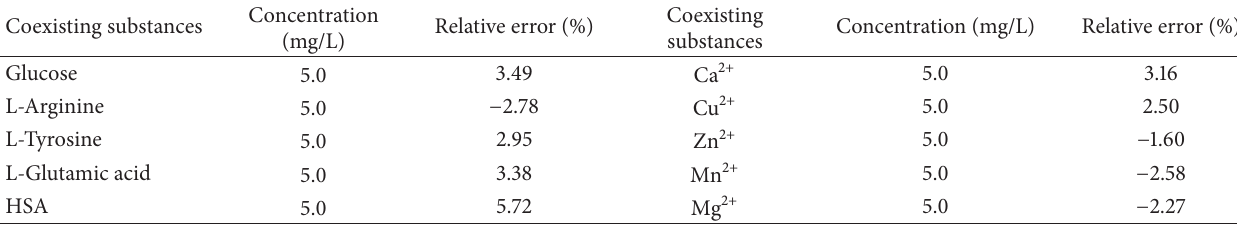
Table 1: Effect of coexisting substances on the determination of 3.0 mg/L PTH.